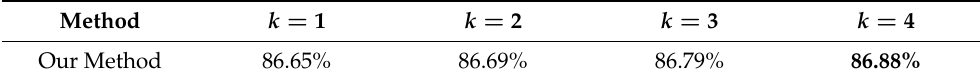
Table 5. Classification results of our method with different k values on the NWPU-RESISC45 dataset.